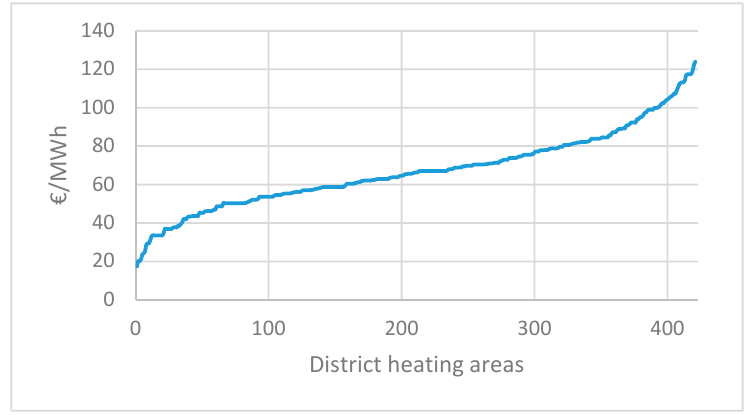
Figure 3. District heating consumer prices for all 422 district heating areas in Denmark. Data from [36].